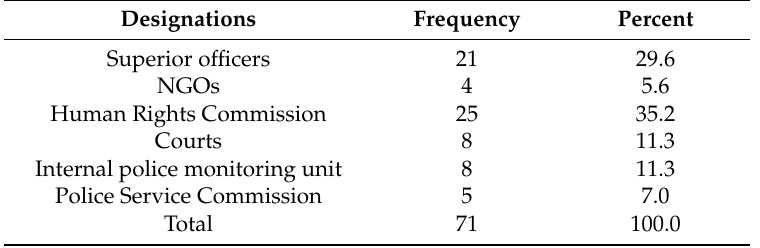
Table 8. The responses on who should be responsible for monitoring police